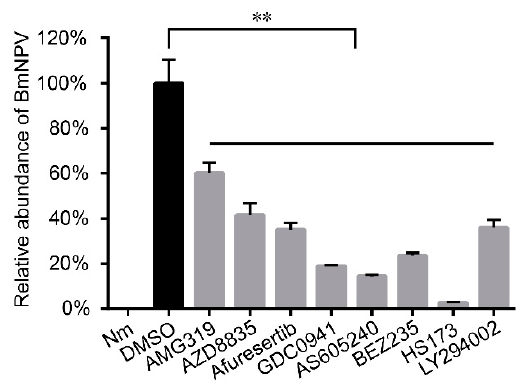
Figure 3. The quantitative polymerase chain reaction (qPCR) analysis of accumulated virus DNA at 48 hpi in BmE cells that were infected with BmNPV-GFP at MOI 1 and administered 10 µM of each drug. Bars: standard deviation; ** p < 0.01.